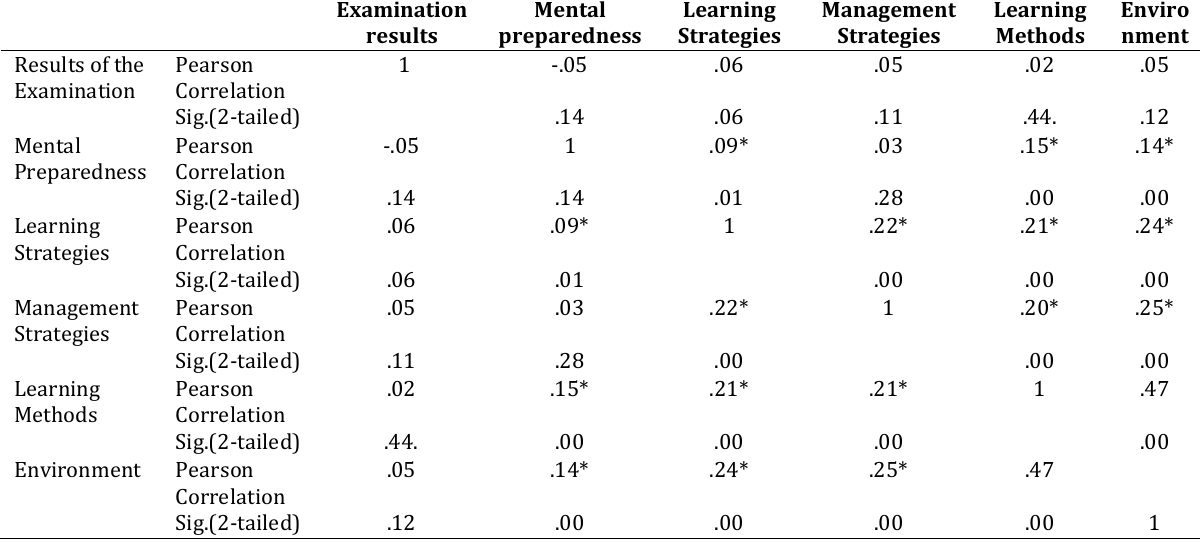
Table 3. The Correlation of Mental Preparedness, Learning Strategies of the Students, Management Strategies, Learning Methods and the Environment (Room Condition) with the Results of the National Nursing Competency Examination in